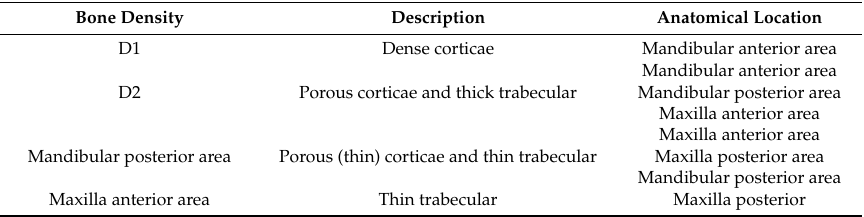
Table 1. Misch’s bone density classification [7].